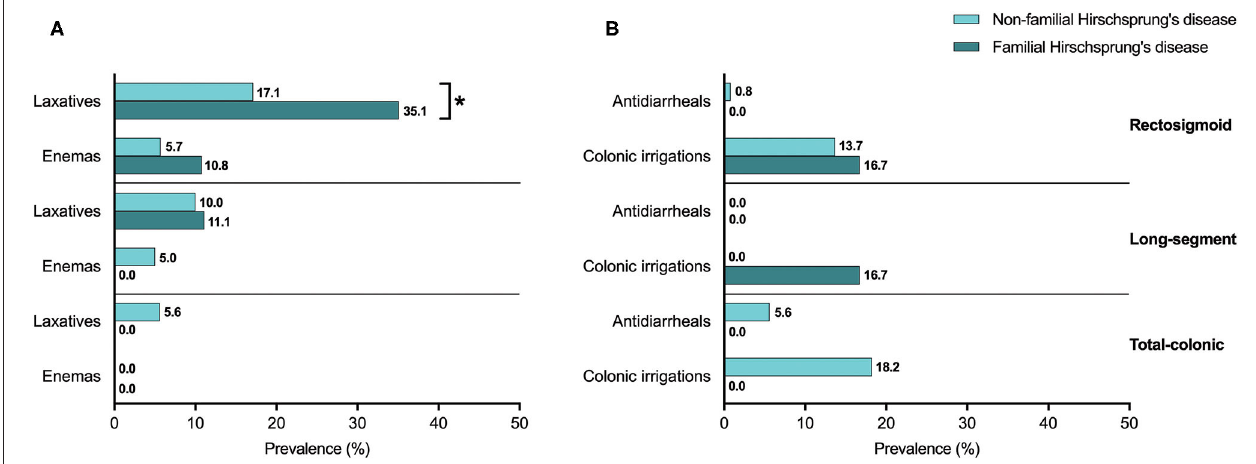
FIGURE 4 | (A,B) The use of defecation treatment in patients with familial and non-familial Hirschsprung’s disease. *Statistical significance of p < 0.05.